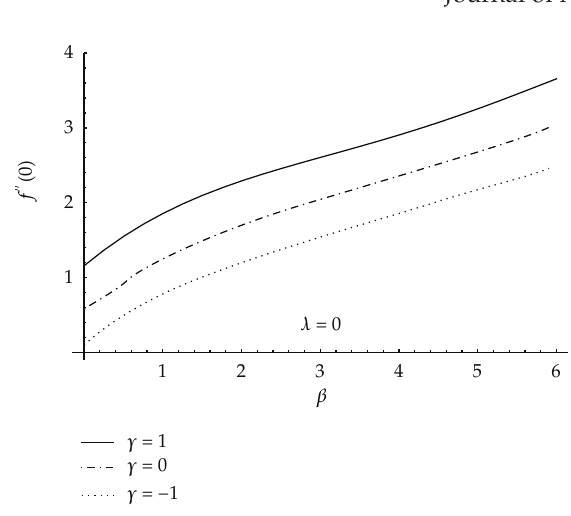
Figure 6: Shear stress f (cid:5)(cid:5) (cid:5) 0 (cid:6) versus the stretching parameter β for various values of the wall suction/injec- tion parameter γ (cid:8) 1 , 0 , − 1.